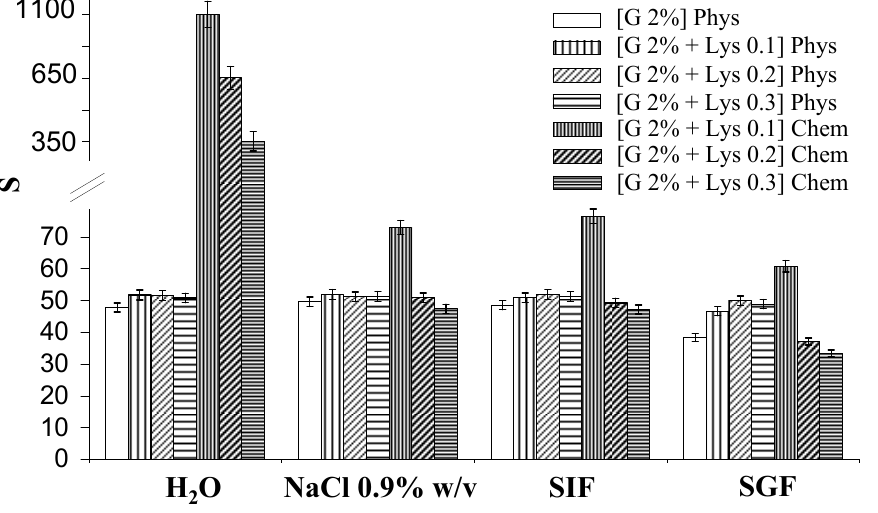
Figure 2. Values of water uptake parameter (S) for the various hydrogels swollen in different media at 37 °C. The data are presented as arithmetic mean of three different measurements, ± SD. (in the legend G =